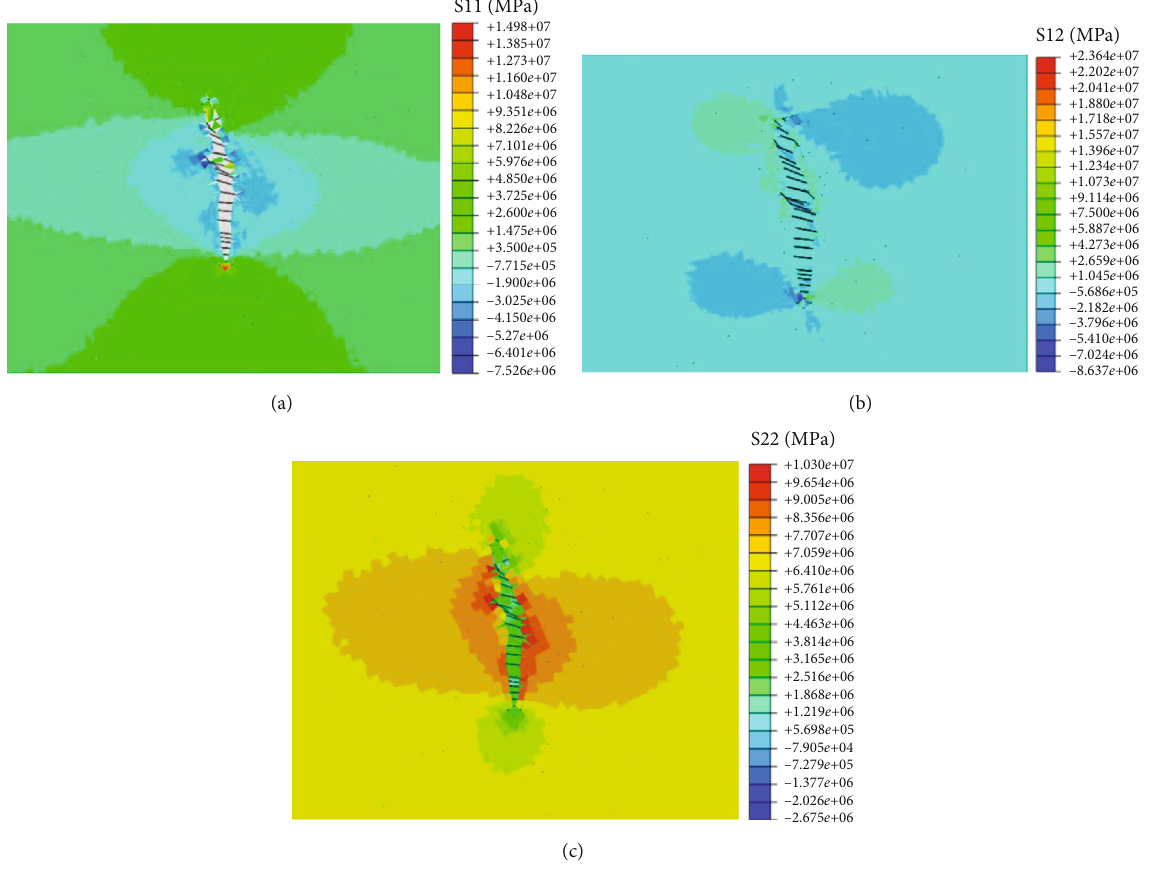
Figure 8: Change of hydraulic fracturing on stress fi eld (unit/MPa) ( HSD = 9 MPa, step time = 42 : 55 s): (a) cloud diagram of σ diagram of shear stress τ ; (c) cloud diagram of σ